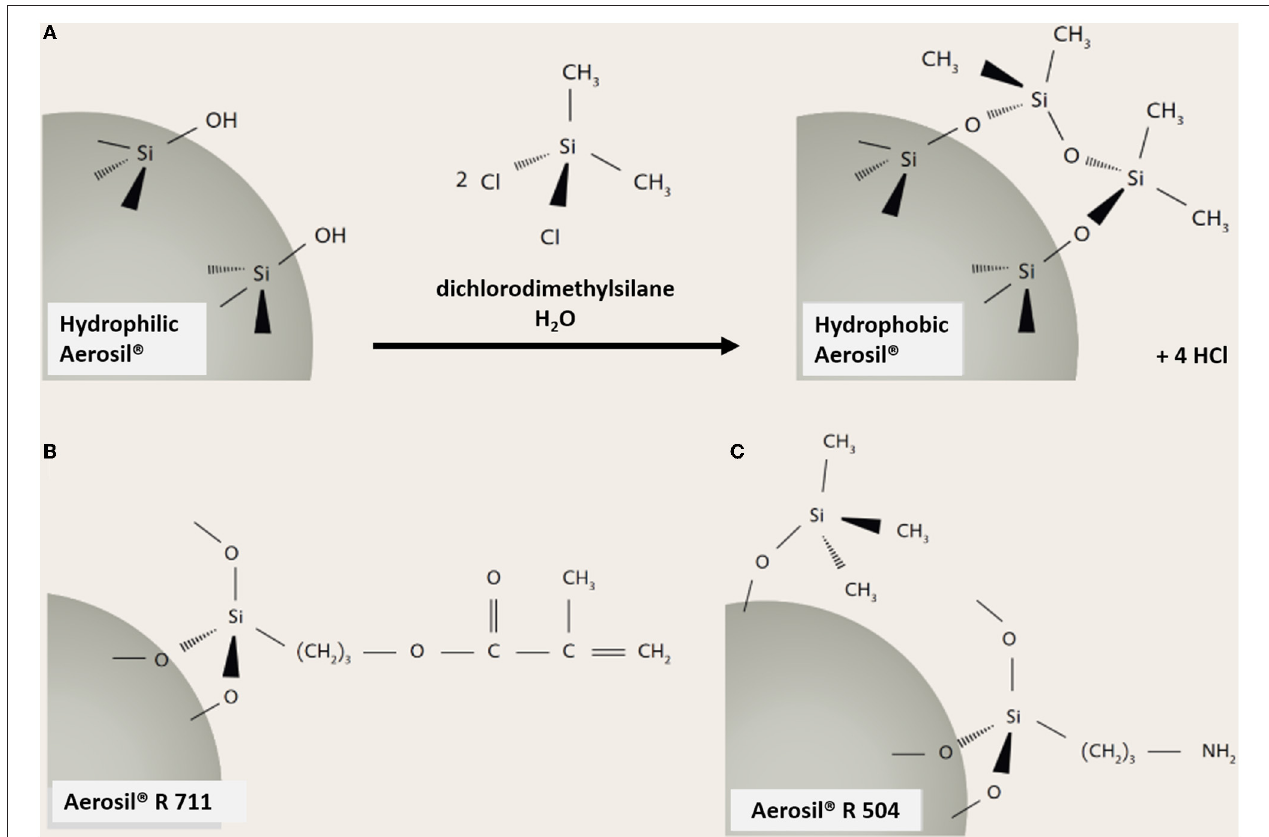
FIGURE 1 | Reaction of organosilanes with silanol groups of SAS and typical reaction products. (A) Reaction of dichlorodimethylsilane (DDS) with a hydrophilic Aerosil ® generates a hydrophobic AEROSIL ® ; (B) methacrylate functionalities at the surface of AEROSIL ® R 711; (C) partly aminated surface of AEROSIL ® R 504. All parts of this figure are taken from “Evonik Industries. AEROSIL ® —Fumed Silica, Technical Overview”